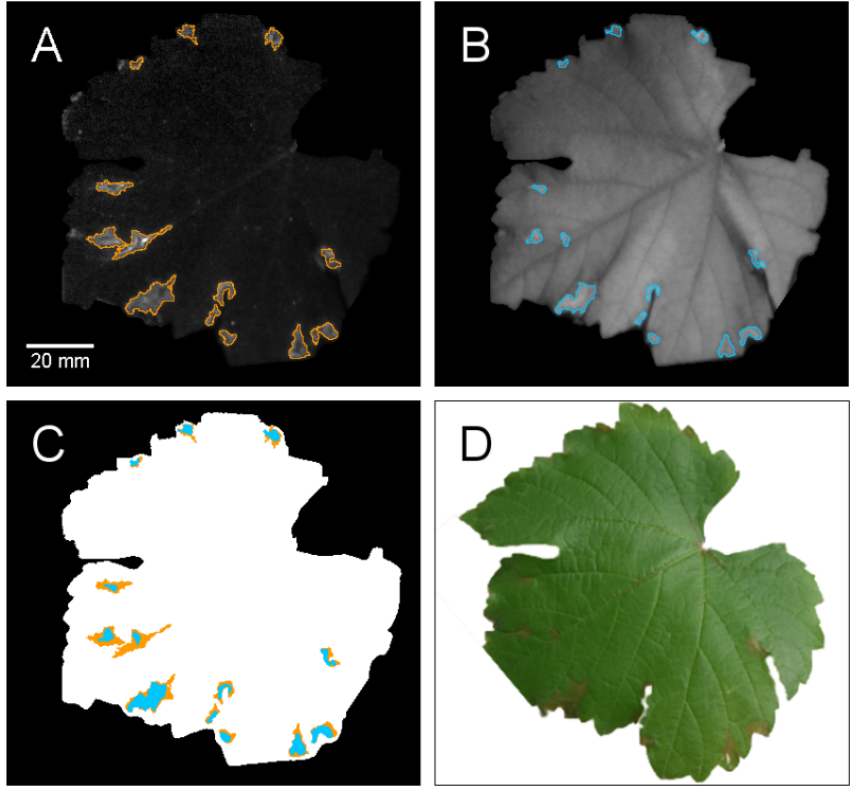
Figure 2. Images of a grapevine leaf infected with the black rot disease caused by Guignardia bidwellii 11 days after an artificial spray inoculation (11 dai (days after inoculation)). Two different fluorescence images are presented: ( A ) UV-A-excited blue fluorescence ( 340 F440) and ( B ) fluorescence at 689 nm excited with blue light ( 447 F689); ( C ) Joint presentation of the ROIs (regions of interest) obtained from the disease symptoms of the fluorescence images in panel A and B. The distribution of the symptoms is shown as colored areas, panel A and B are displayed in orange and light blue areas, respectively; ( D ) Photograph of the infected grapevine